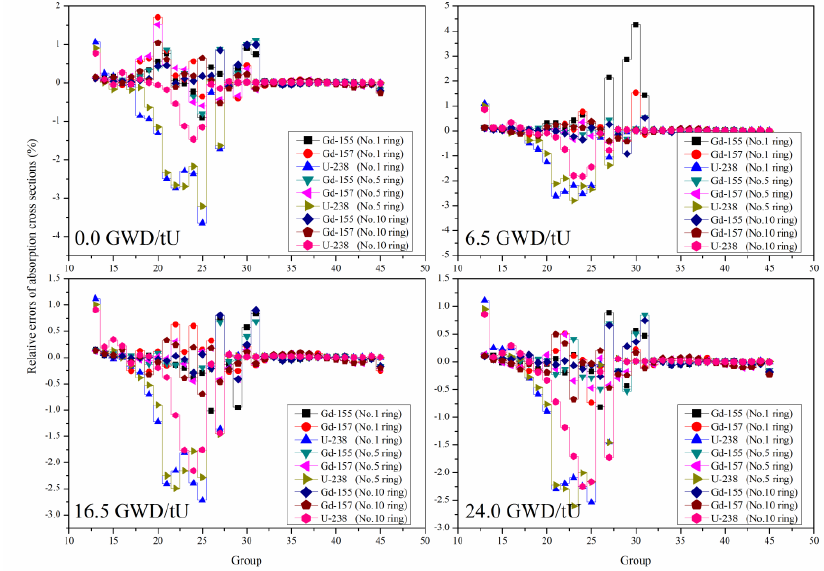
Figure 6. Change of atom densities of Gd-155 and Gd-157 with